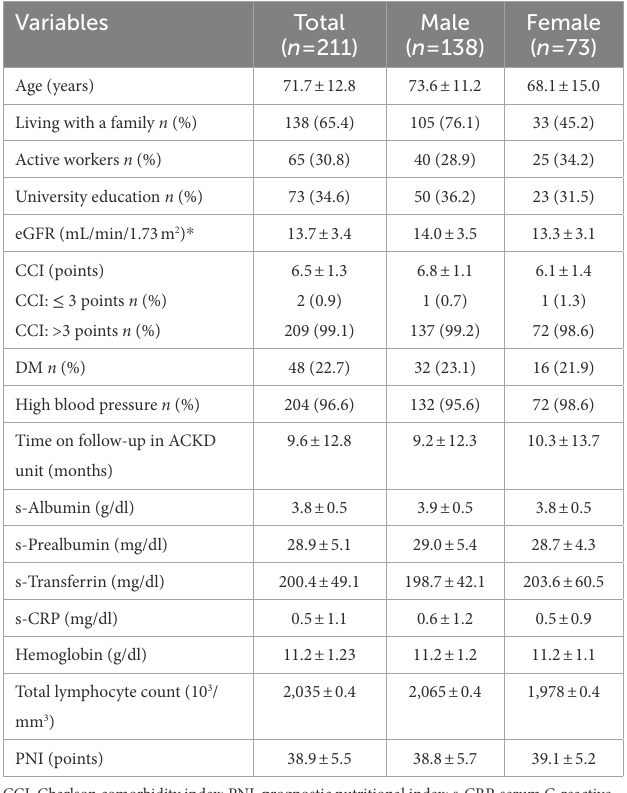
TABLE 1 Clinical and biochemical parameters characteristics of 211 participants in the study and by gender.